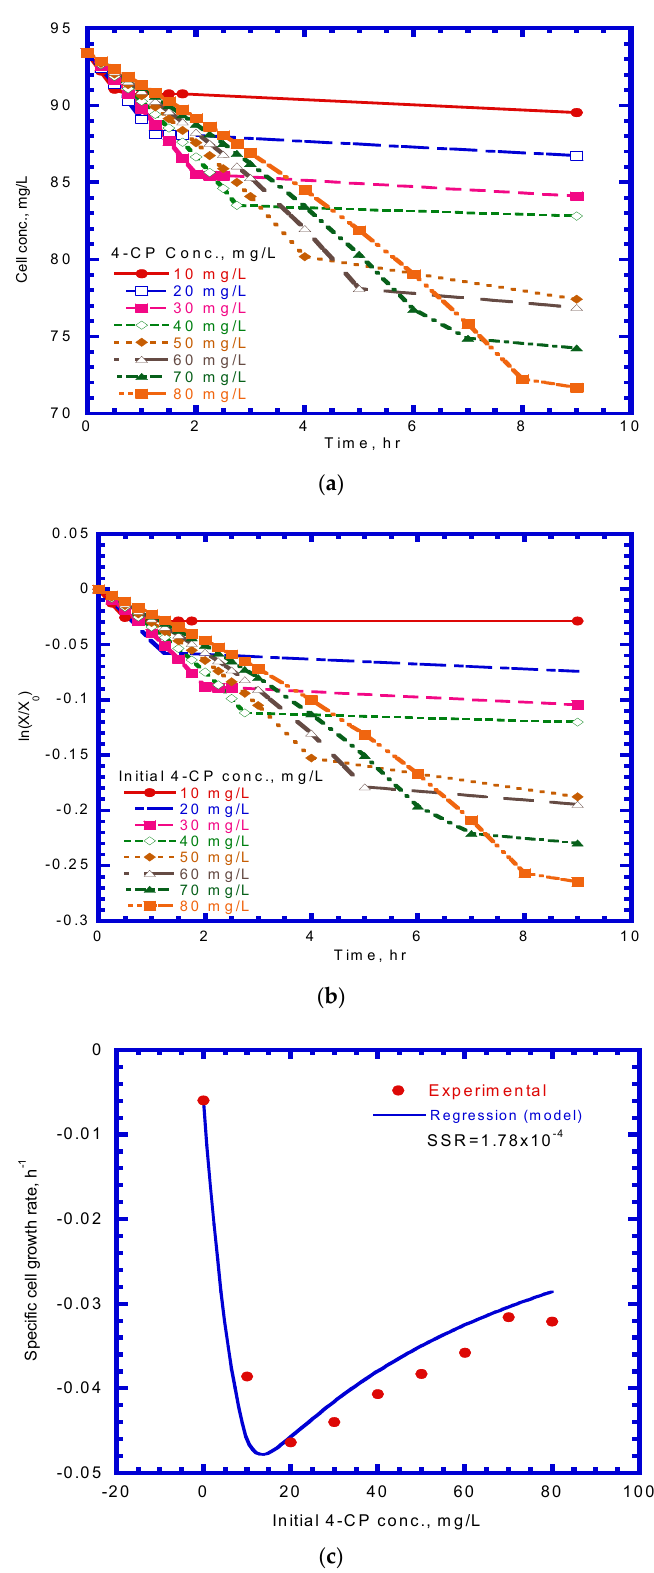
Figure 7. Batch tests to determine kinetic parameters of true cells’ transformation capacity and first-order endogenous decay coefficient: ( a ) time course variation of cell concentration; ( b ) time course variation of ln(X/X 0 ) to determine specific growth rate; ( c ) variation of specific growth rate with initial 4-CP